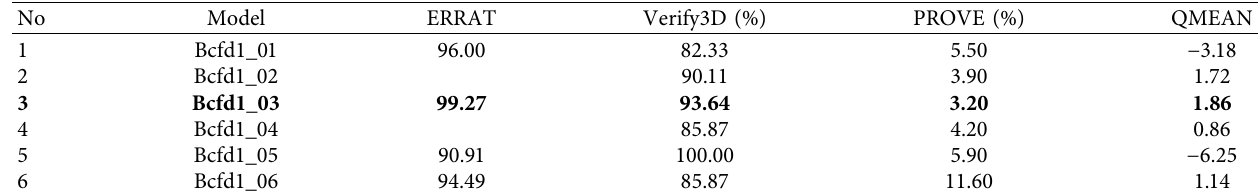
Table 1: The 3D profile and geometrical aspects evaluation of the Bcfd1 structure models.